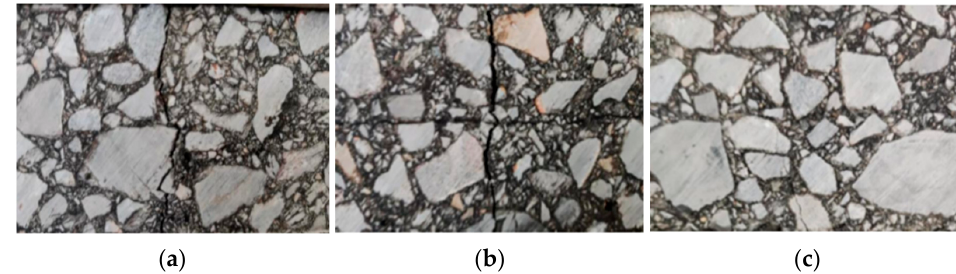
Figure 6. Crack propagation diagram of the AC-13C. ( a ) Unreinforced, ( b ) geotextile, ( c ) geogrid.